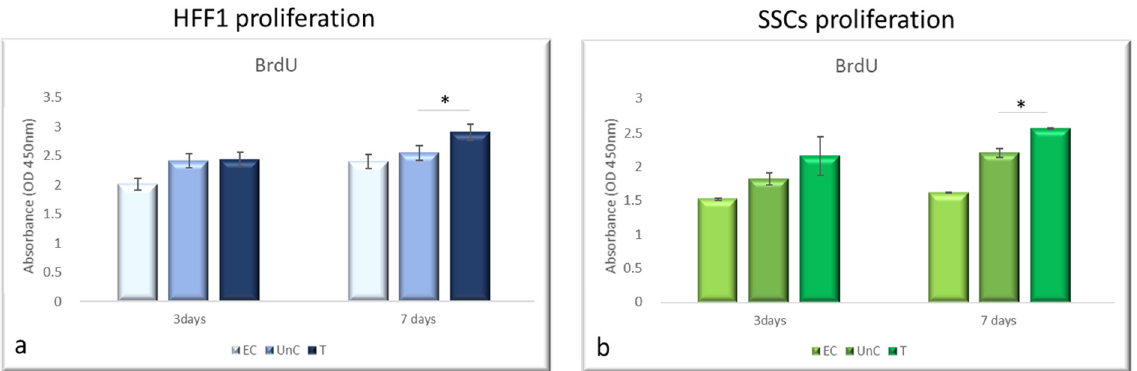
Figure 3. Effect of pre-treatment with NanoPCL-M on cell proliferation. HFF1 ( a ) and SSCs ( b ) were pre-treated with NanoPCL-M for 3 and 7 days, and then exposed to UV light as described. Cell viability is expressed in OD units as compared with untreated cells UnC. Data are expressed as mean ± SD referring to the control. * p ≤ 0.05.